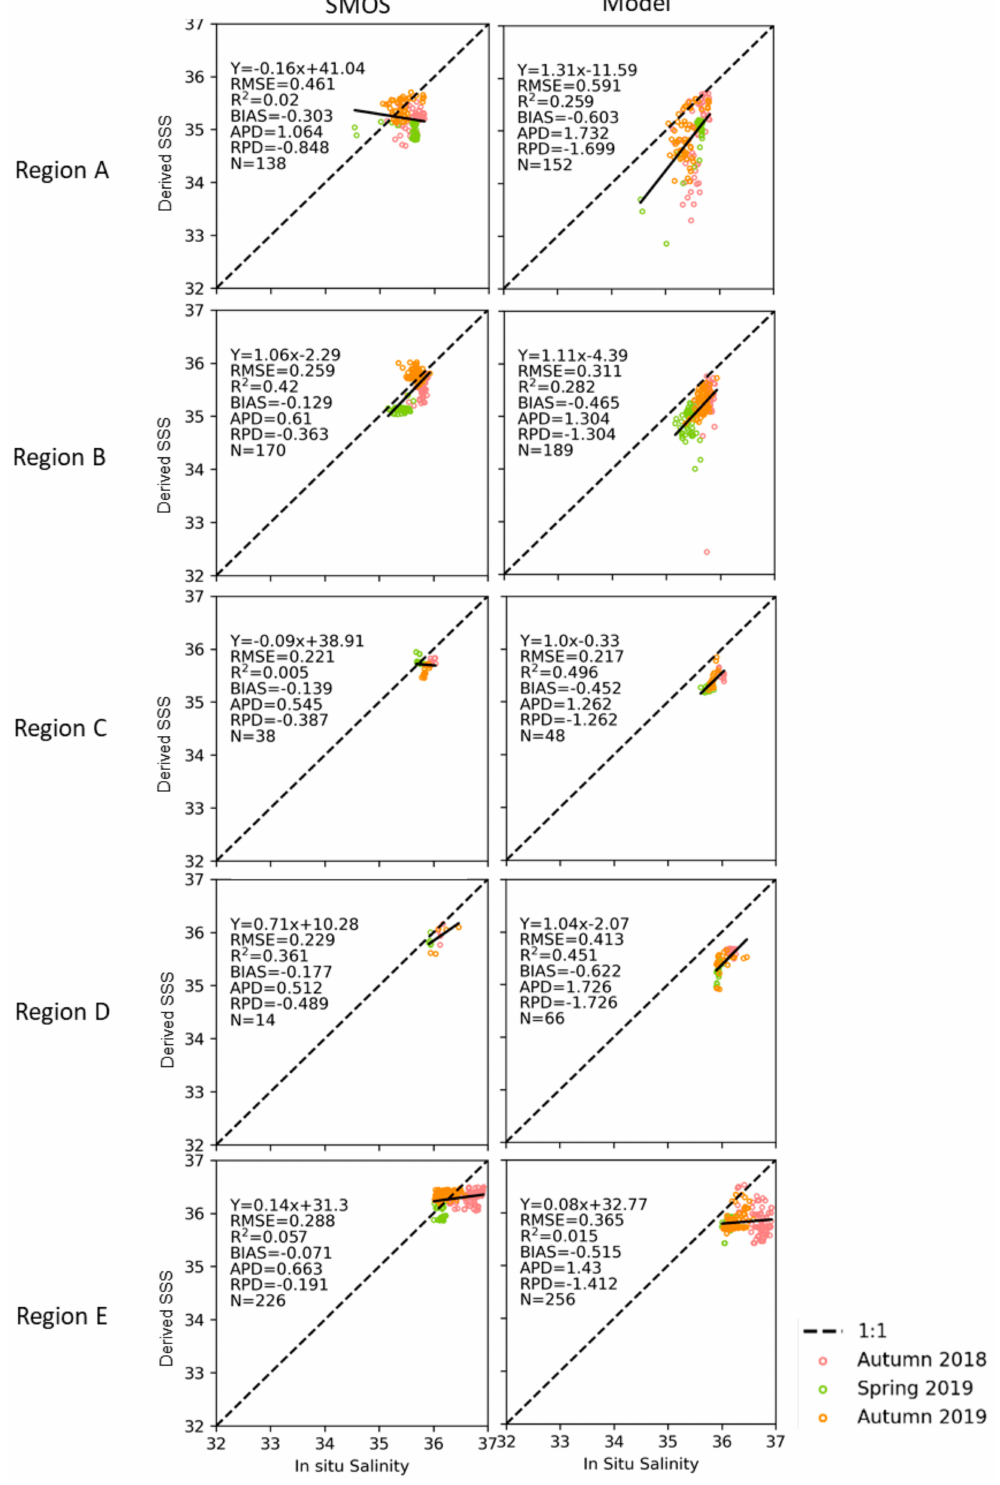
Figure 4. Comparison of the satellite and model–derived data with the in situ observations. Matchups plotted according to the region of study and colored by the season of the year (sampling cruises). 1:1 line indicates ideal correspondence. APD and RPD values are in